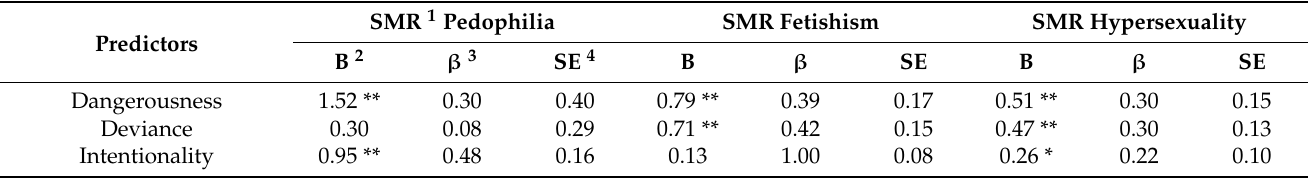
Table 3. Predictors of Punitive Attitudes toward People with Pedophilia, Fetishism, and Hypersexuality. SMR 1 Pedophilia SMR Fetishism Predictors Dangerousness 1.52 ** Deviance 0.30 Intentionality 0.95